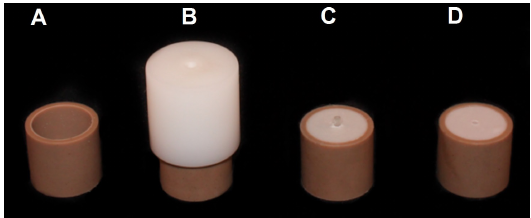
Figure 1. Matrices and system guides. A) PVC ring; B) Polyacetal matrix placed over PVC ring; C) Set PVC, ring, silicon and fiberglass post White Post DC nº 3; D) Simulated conduct